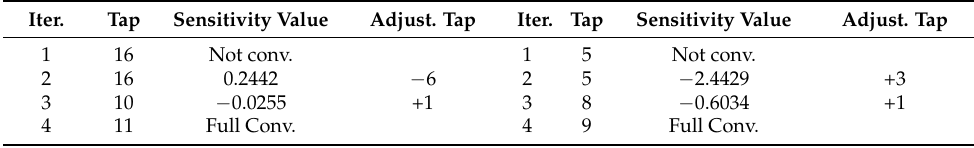
Table 11. Sensitivity and tap position per iteration for Case 11.